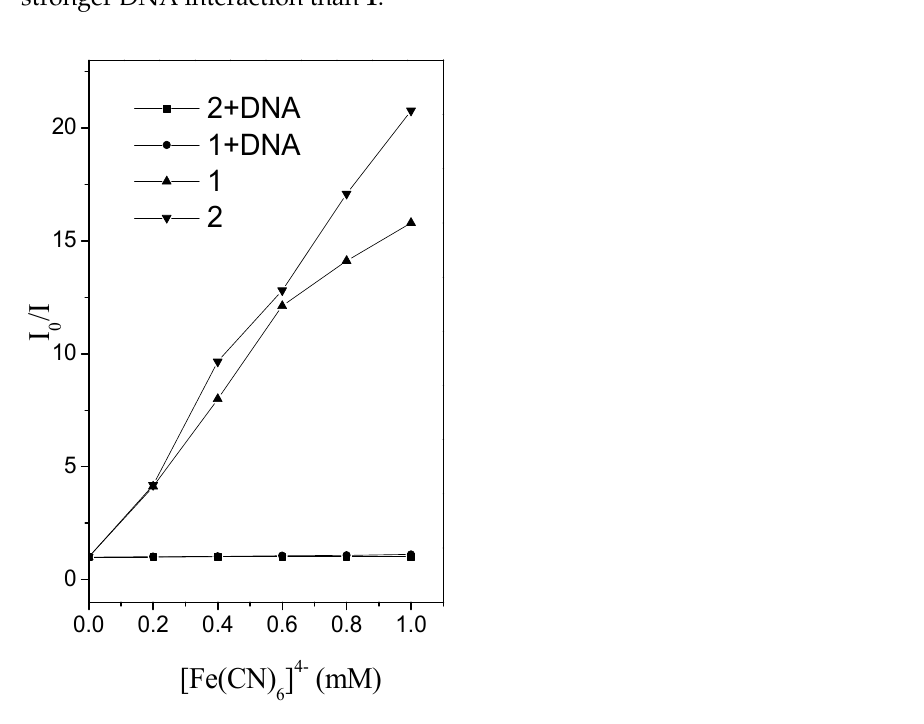
Figure 4. Luminescence quenching curves of two complexes (5 μ M) without or with DNA (400 μ M) at various concentrations of [Fe(CN) 6 ] 4 − at various concentrations of [Fe(CN) 6 ] 4 − .